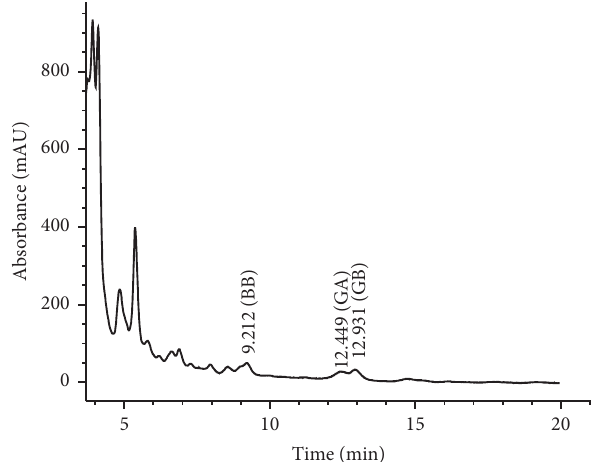
Figure 5: Chromatogram of G. biloba tea